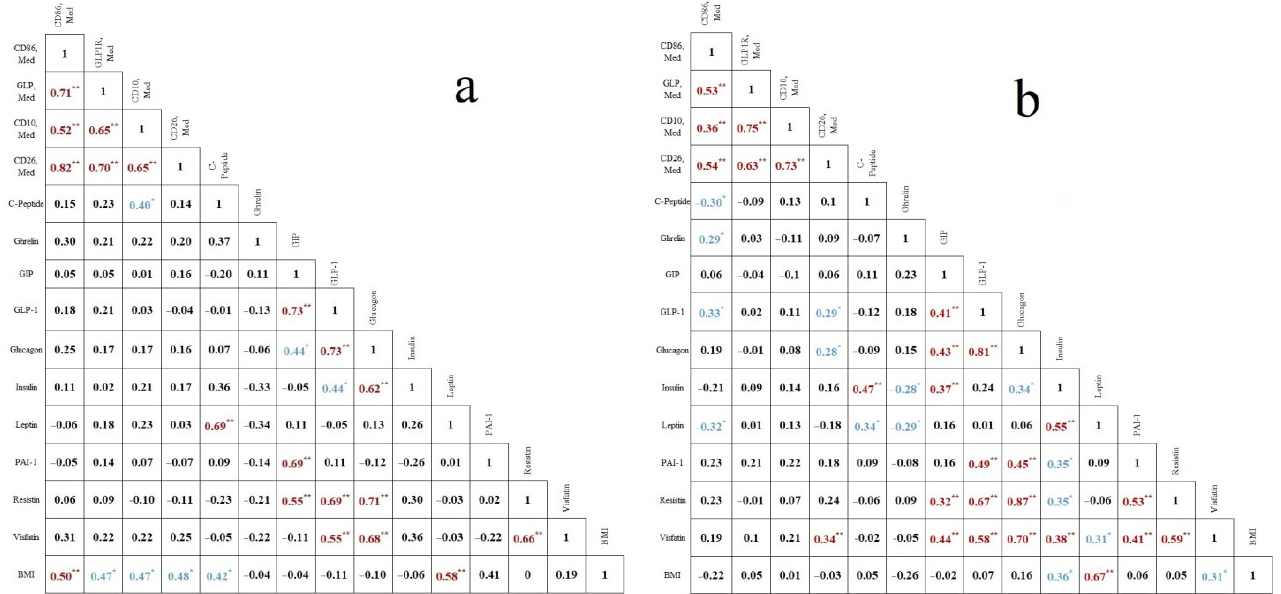
Figure 1. Concentrations of energy metabolism factors in the PF in control and endometriosis groups, * — p < 0.05, ** — p < 0.01.